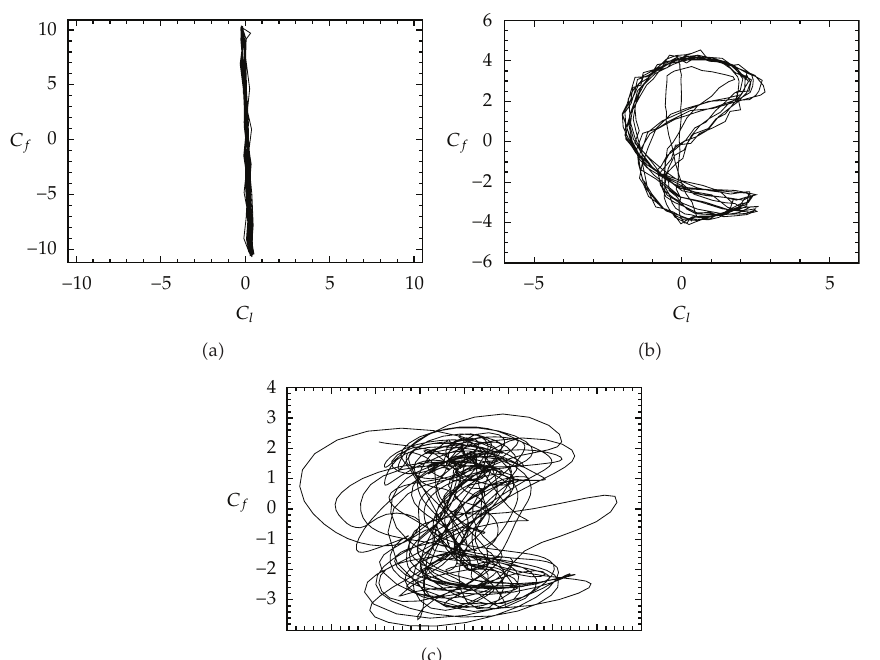
Figure 12: Phase diagrams of C f versus C l of the first cylinder at KC (cid:8) 2, 5, and